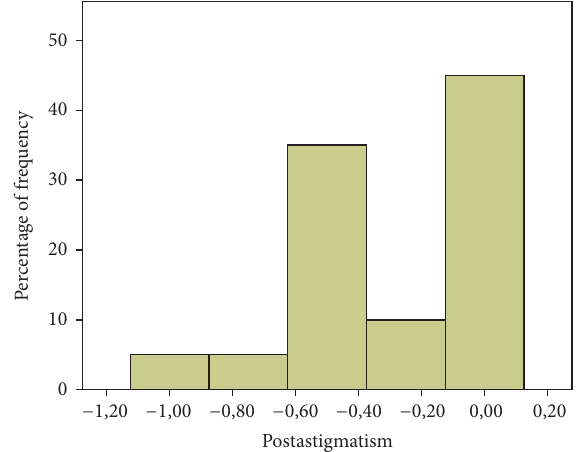
Figure 5: Histogram of postoperative refractive cylinder showing that86%ofthepatientspresentedapostoperativerefractivecylinder lower than −